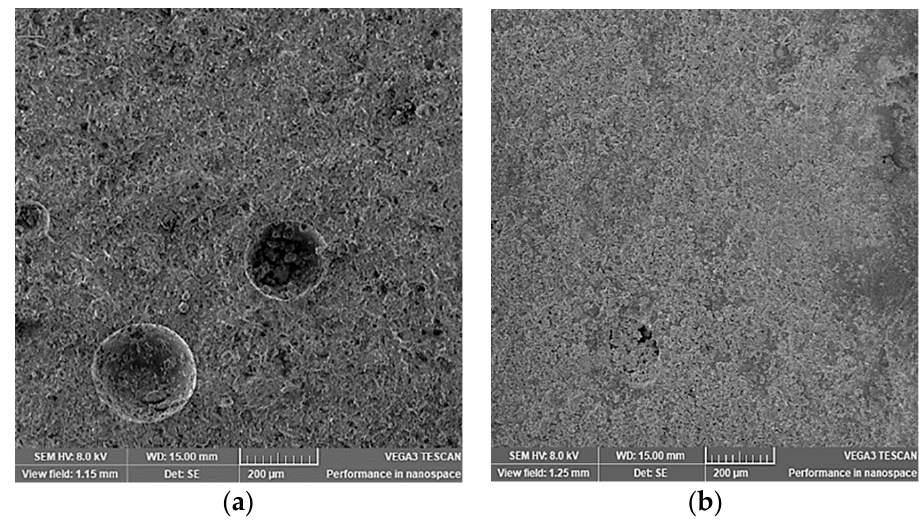
Figure 5. SEM images of ( a ) CP and ( b ) CP10VSW samples surface topography.